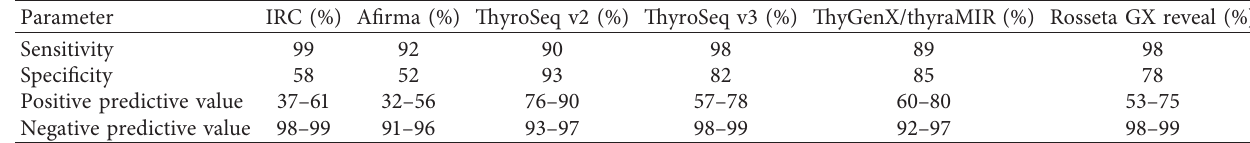
IRC: immune-related